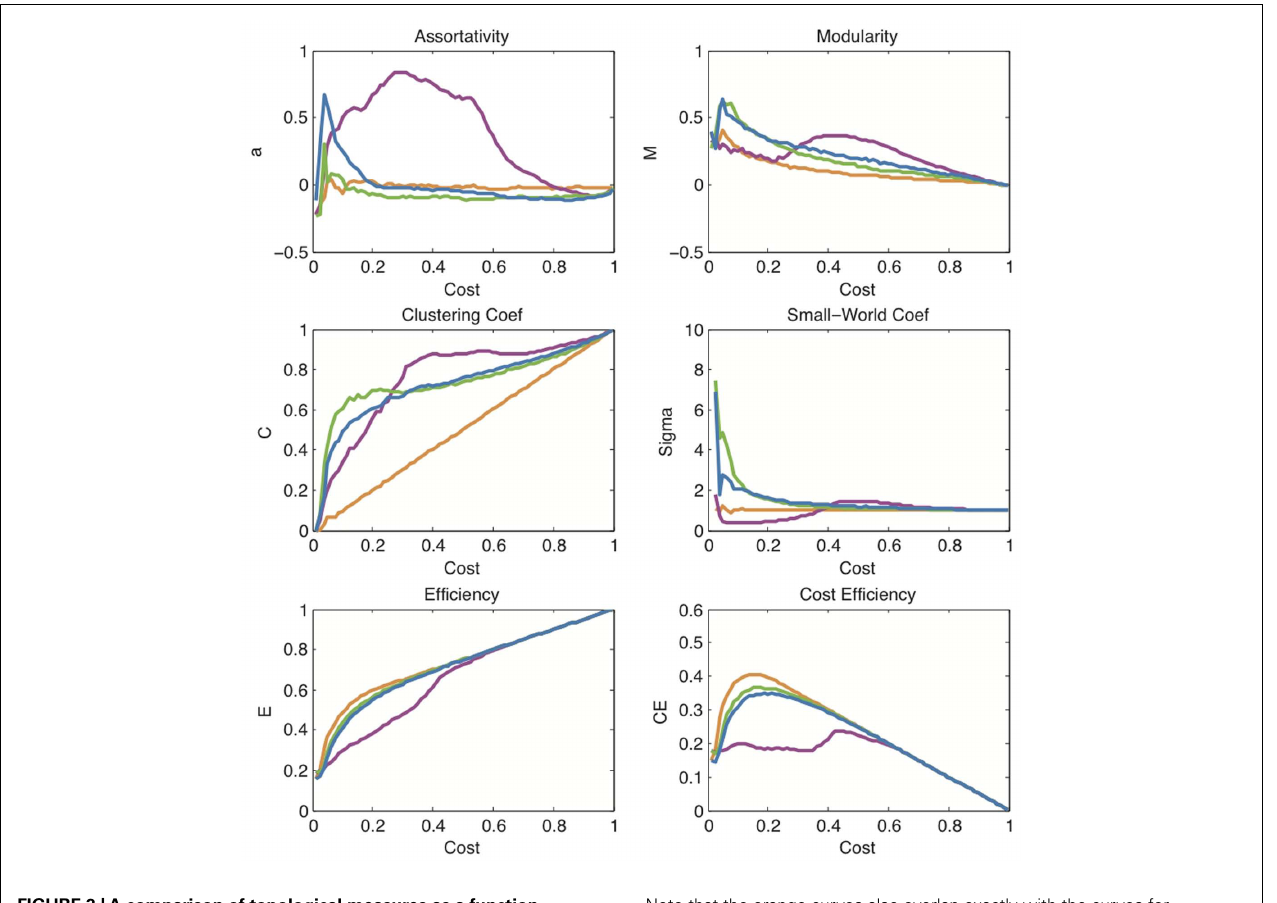
FIGURE 3 |A comparison of topological measures as a function of connection density. These plots show the evolution of various network measures with increasing cost in the financial network (green), the brain functional network (blue), the political network (magenta), and the model network based on Black–Scholes (orange).